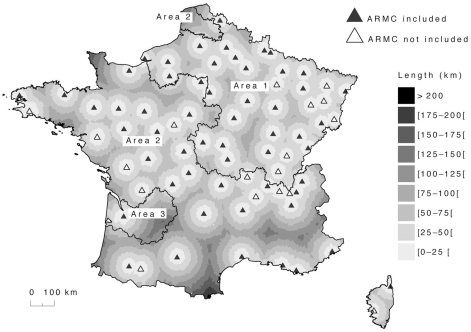
Spatial distribution of French AntiRabies Medical Centers (ARMC).The minimal distance to any of the 74 ARMC is illustrated (grey scale); 93% of the 36,539 districts are <75 km from an ARMC. France has been divided into three areas, according to their rabies experience: area 1 corresponds to the former zone harboring rabies-infected foxes (19,132,787 inhabitants); area 2, has no history of rabies events (37,423,439 inhabitants); and area 3, where rabies event #6 occurred (1,981,313 inhabitants).